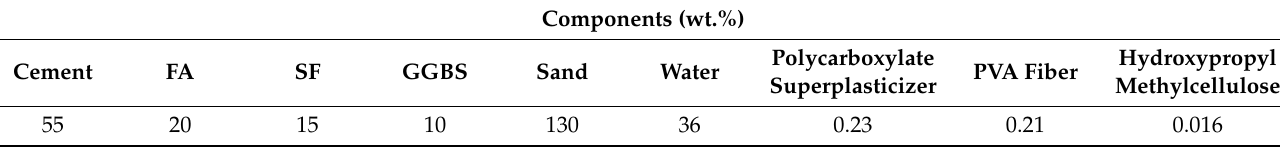
Table 3. Control mix proportion of this